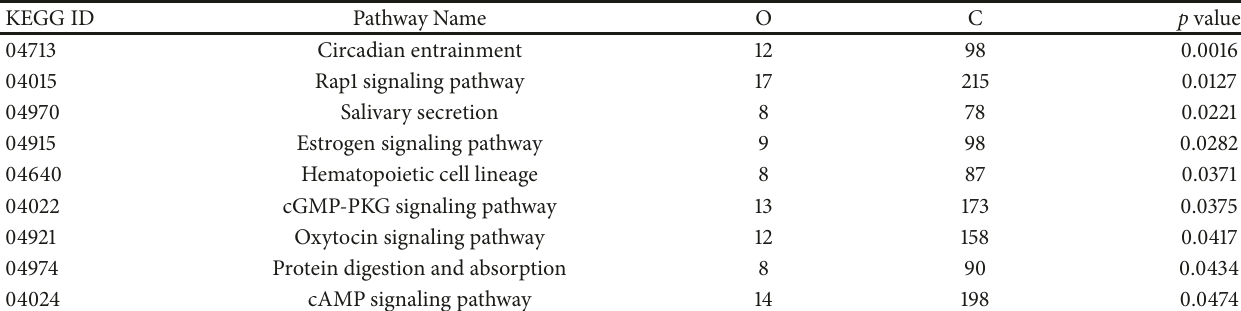
Table 1: Kyoto Encyclopedia of Genes and Genomes (KEGG) pathways of differentially expressed genes in the HFG group ( p < 0.05).